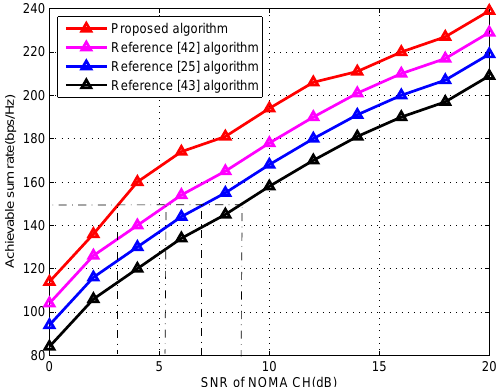
Figure 10. Comparison of the achievable sum-rate under different